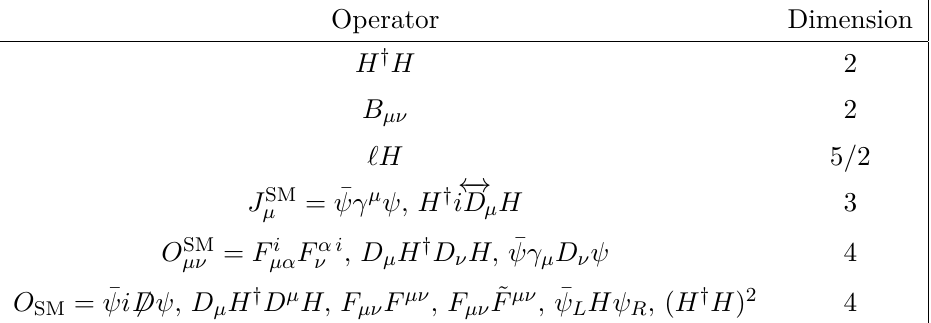
Table 1 . List of the SM gauge-singlet operators with (classical) dimension equal or smaller than 4. Here ψ and F stand respectively for any SM fermion and any SM gauge field µν